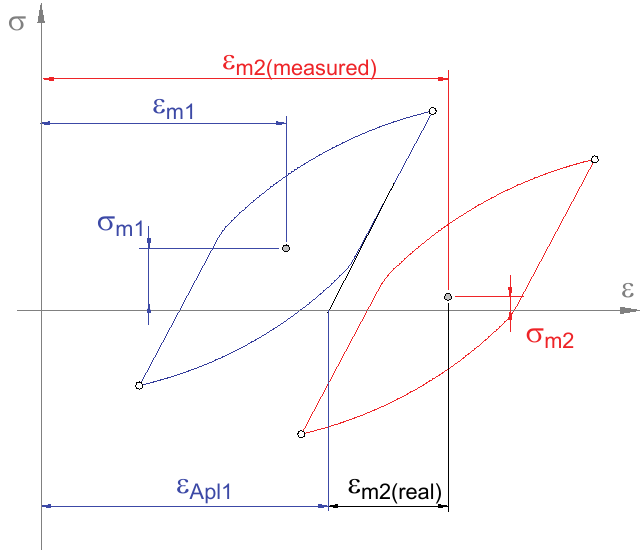
Figure 3: Location of the hysteresis loops for the next sequence in the block